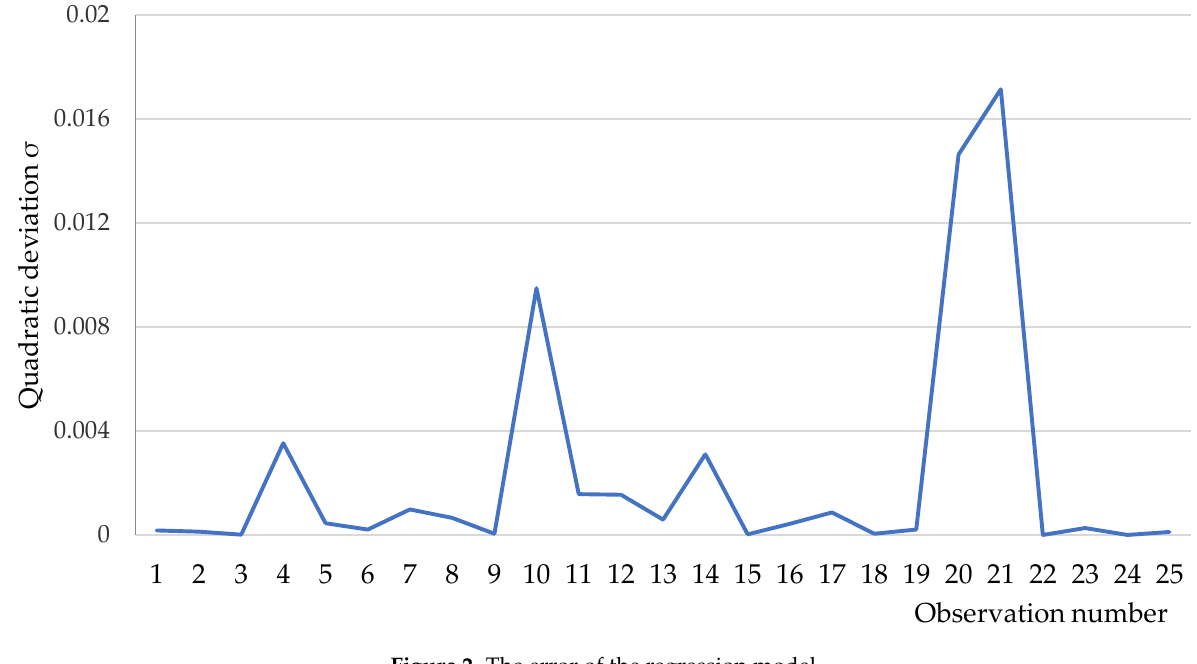
Figure 2. The error of the regression model.